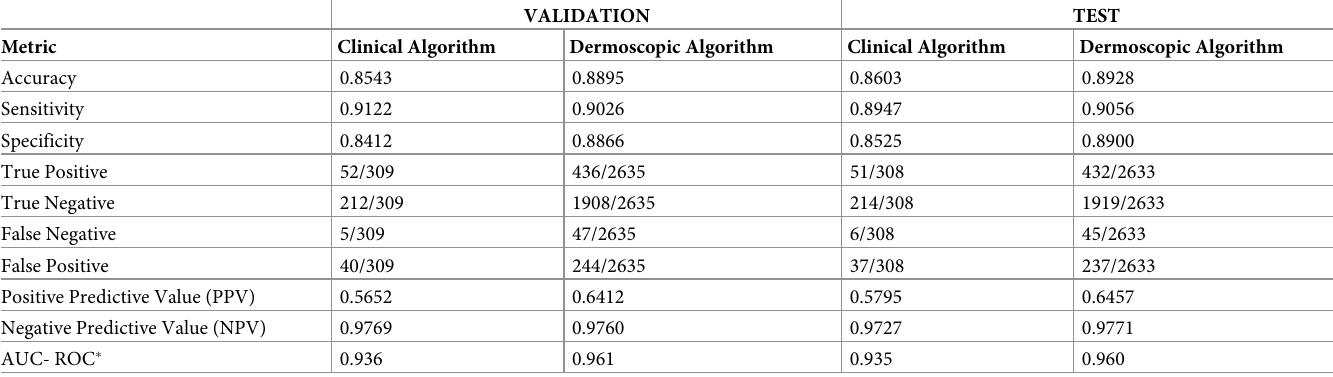
Table 2. Performance of the algorithms in validation and in test